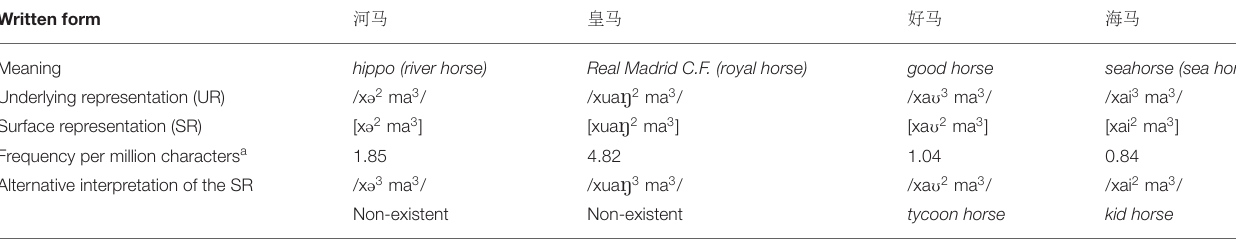
TABLE 2 | Relevant information of lexical items used in the present study (the phonetic notations are IPA). Written form 河 马 皇